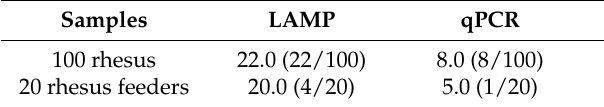
Table 2. Detection of B. quintana in test samples of rhesus blood and rhesus-feeder blood by LAMP and